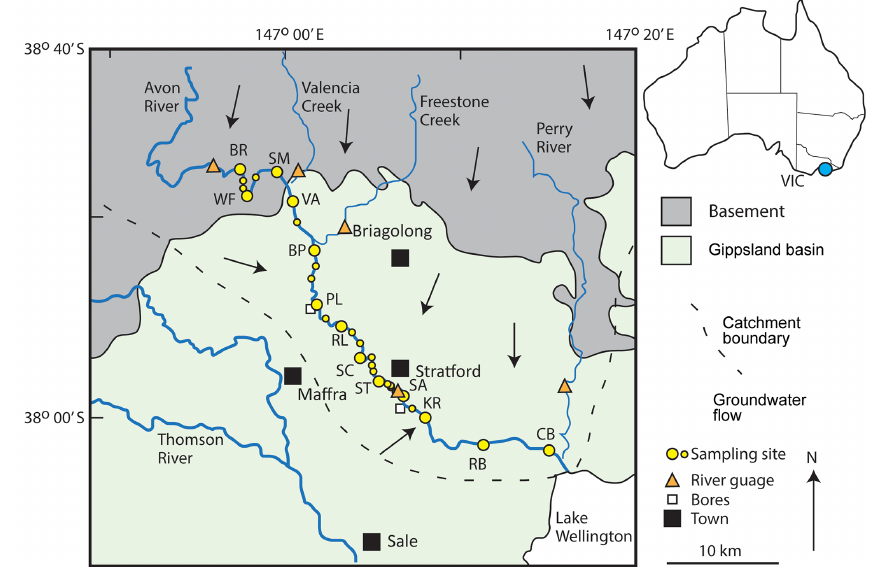
Figure 1. Summary geological and hydrogeological map of the Avon River catchment (Hofmann and Cartwright, 2015; Department of Environment and Primary Industries, 2015). Arrows show general direction of groundwater flow. Main sampling sites (in order of distance downstream are) are BR: Browns, WF: Wombat Flat, SM: Smyths Road, VA: Valencia, BP: Bushy Park, PL: Pearces Lane, RL: Ridleys Lane, SC: Schools Lane, ST: Stewarts Lane, SA: Stratford, KR: Knobs Reserve, RB: Redbank, CB: Chinns Bridge. Unnamed sampling sites are the additional sites from February 2015 (Table